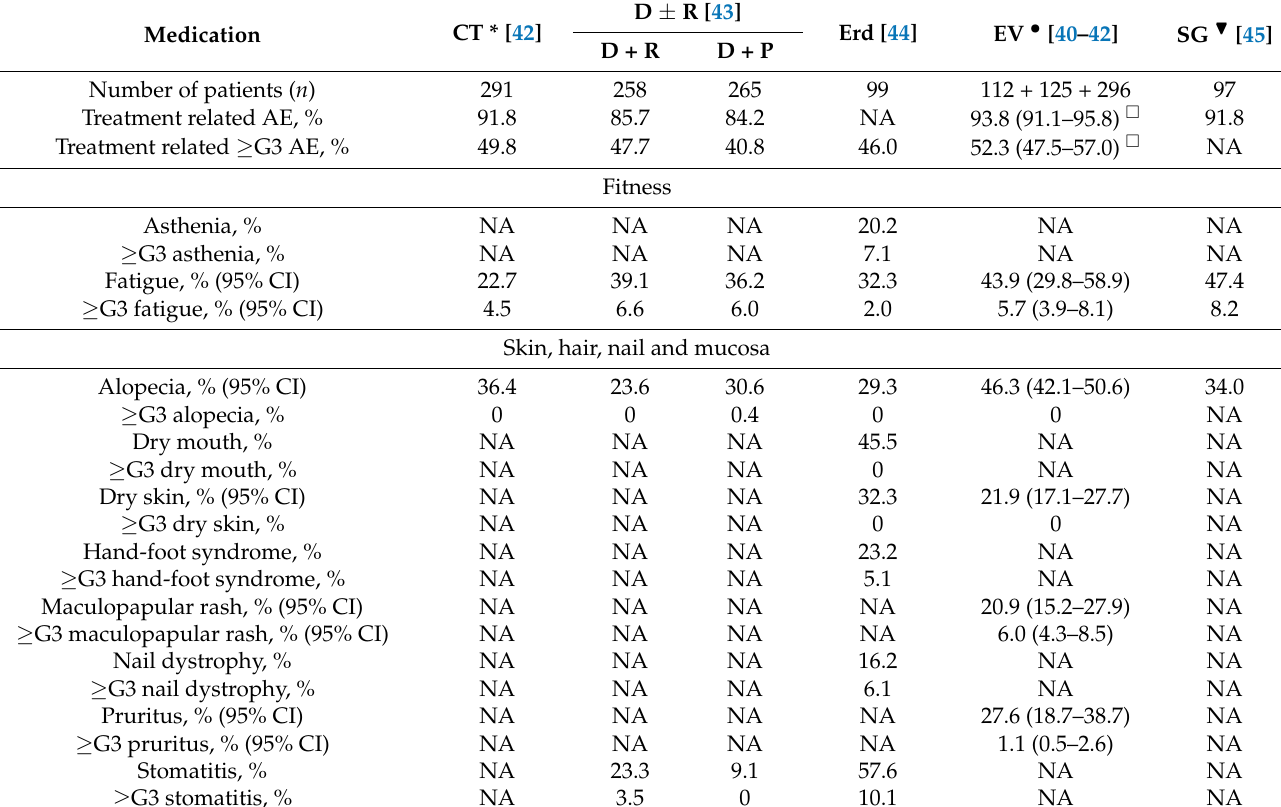
Table 3. All data presented in percentage terms. * Paclitaxel, Docetaxel, Vinflunine. • pooled data, EV dosage of 1.25 mg/kg (cid:3) of body weight. Data only available for n = 125 [41] + 296 [42]. of body